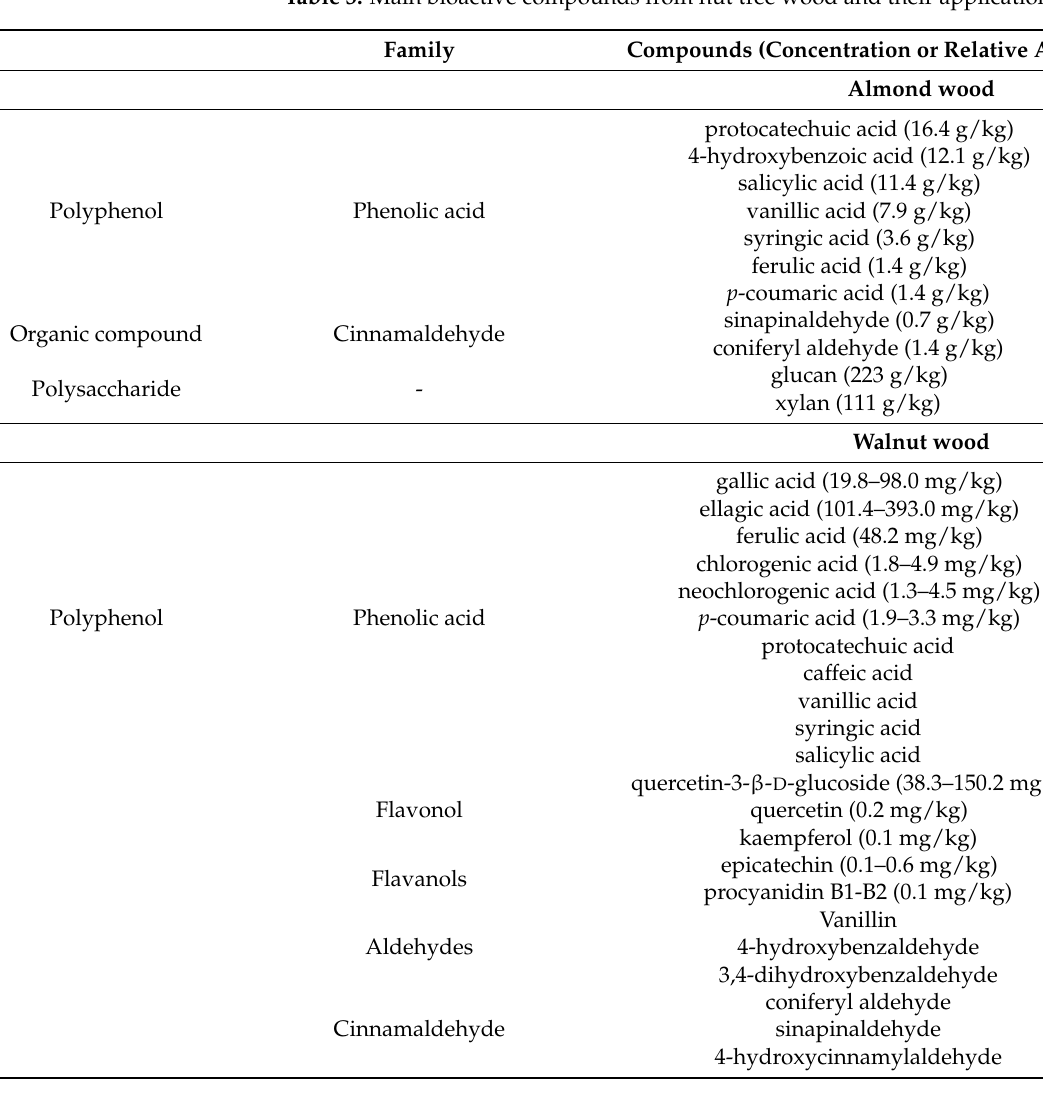
Table 3. Main bioactive compounds from nut tree wood and their applications. * ↑ : Increase; ↓ : Decrease. Chemical structures by families are shown in Figure